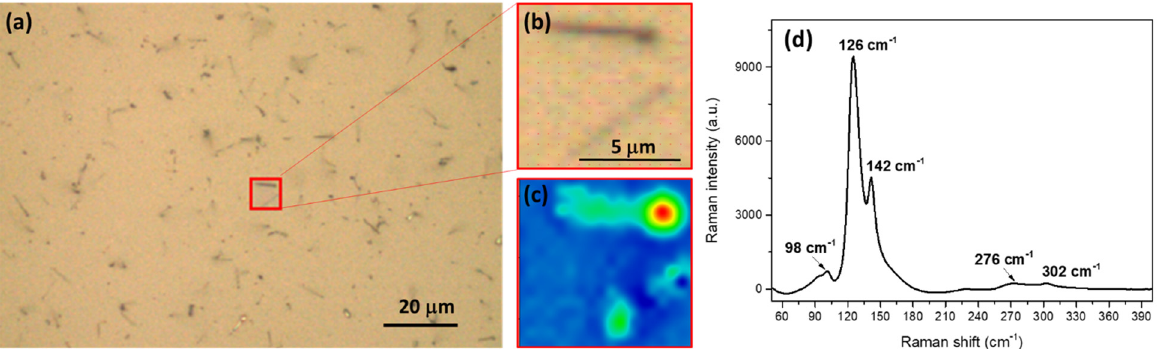
Figure 3. ( a ) Large-area optical image of GeTe core NWs on a SiO 2 substrate with 20 nm Au NPs; ( b ) High magnification micrograph localizing single NWs; ( c ) 2D Raman map acquired on the selected area of ( b ). The colour representation refers to point-by-point correlation with the Raman spectrum, averaged over the full length of the NW identified on the upper part of the map and reported in ( d ).